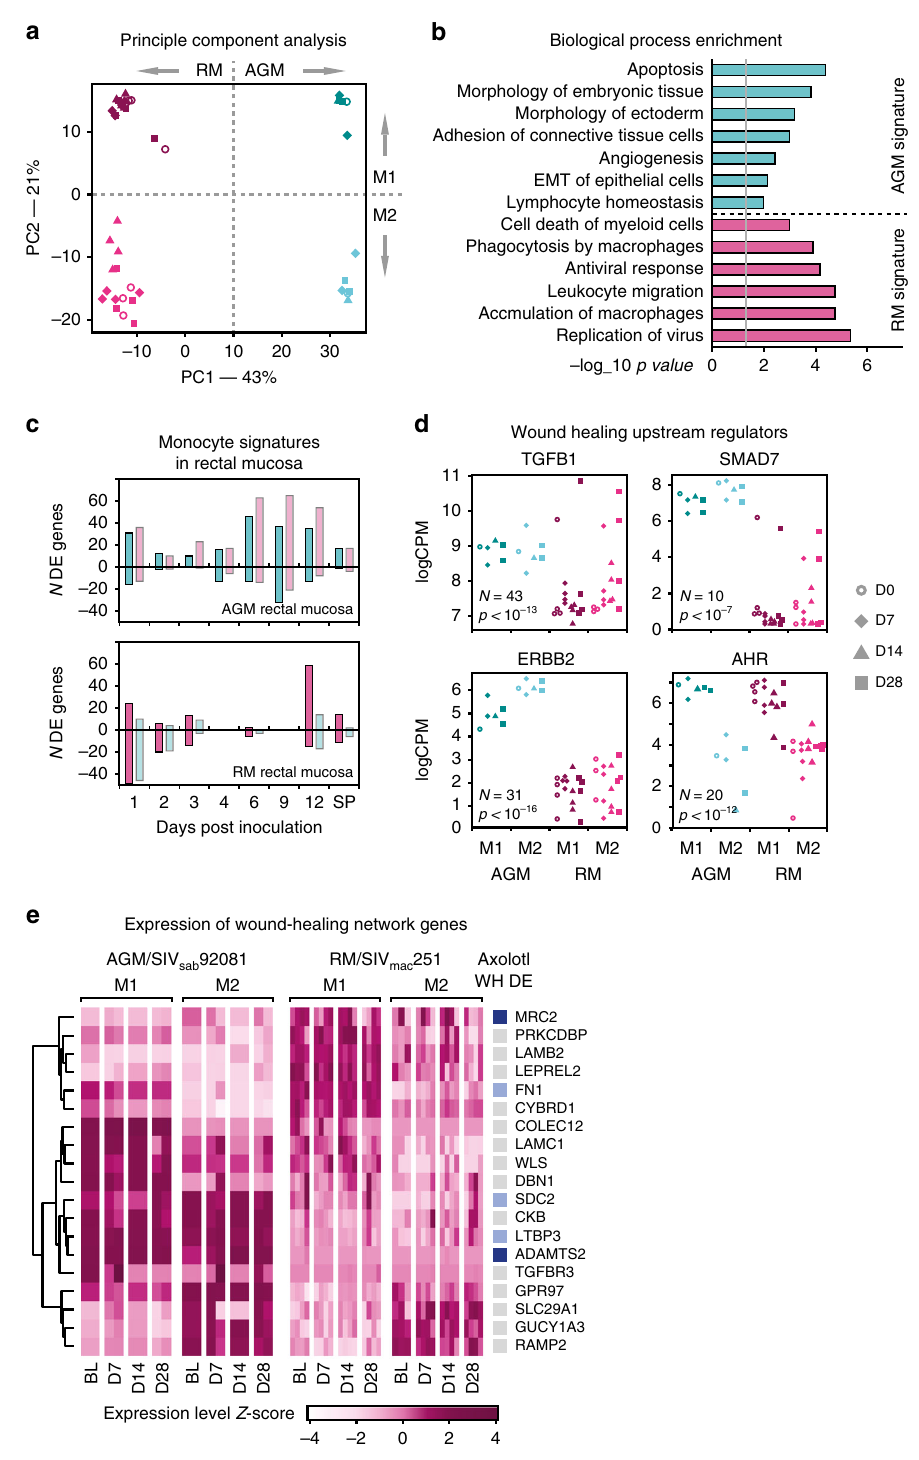
Fig. 7 Monocyte pro fi ling from separate set of RMs and AGMs. a PCA analysis of 1000 most variable genes, showing clear separation between AGM (teal) and RM (pink) monocytes, as well as type M1 (dark color) and M2 (light color). Shapes represent time points: circle — baseline, diamond — d7, triangle — d14, square — d28. b Functional enrichment of the AGM and RM monocyte transcriptomic signatures — each consisted of the 300 genes with the strongest positive and negative correlation to the fi rst PC shown in ( a ). c Number of up- and downregulated genes from AGM and RM rectal mucosa, that overlapped with genes in the AGM or RM monocyte signatures. d Expression levels for predicted upstream regulators of Wound Healing Network genes in the AGM and RM monocytes from peripheral blood. Number indicate the number of regulator target genes in the Wound Healing Network, and p -values pertain to the corresponding enrichment test. Colors and shapes represent species, monocyte subset and time point as in ( a ). e Heatmap showing expression of Wound Healing Network genes in AGM and RM monocytes, with upregulated genes from axolotl wound healing. Since the most variation was introduced by species and monocyte subset, not time point, we show expression Z-score instead of logFC values. The leftmost column shows what genes are signi fi cantly upregulated in axolotl wound healing. Dark blue marks genes upregulated at day 1; light blue marks genes upregulated at day